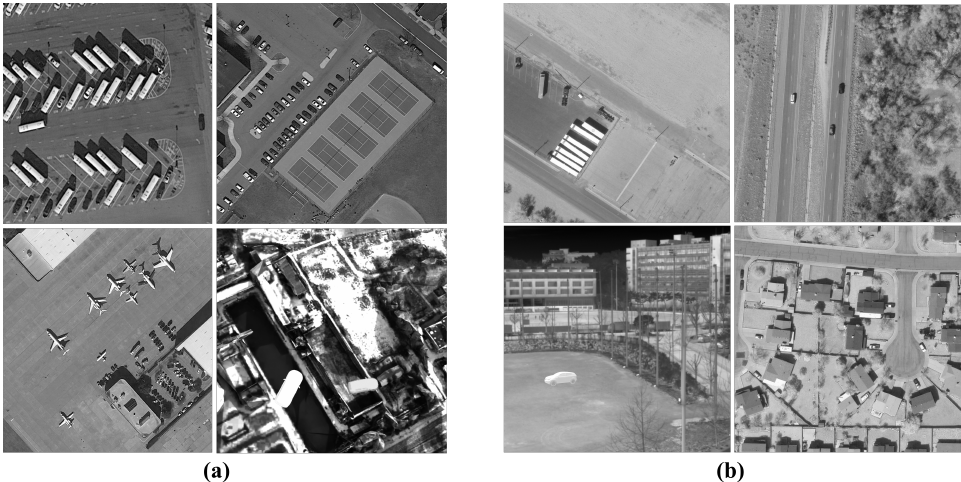
Figure 4. Sample images from datasets. ( a ) Images in visible light spectrum. ( b ) Images in in- frared